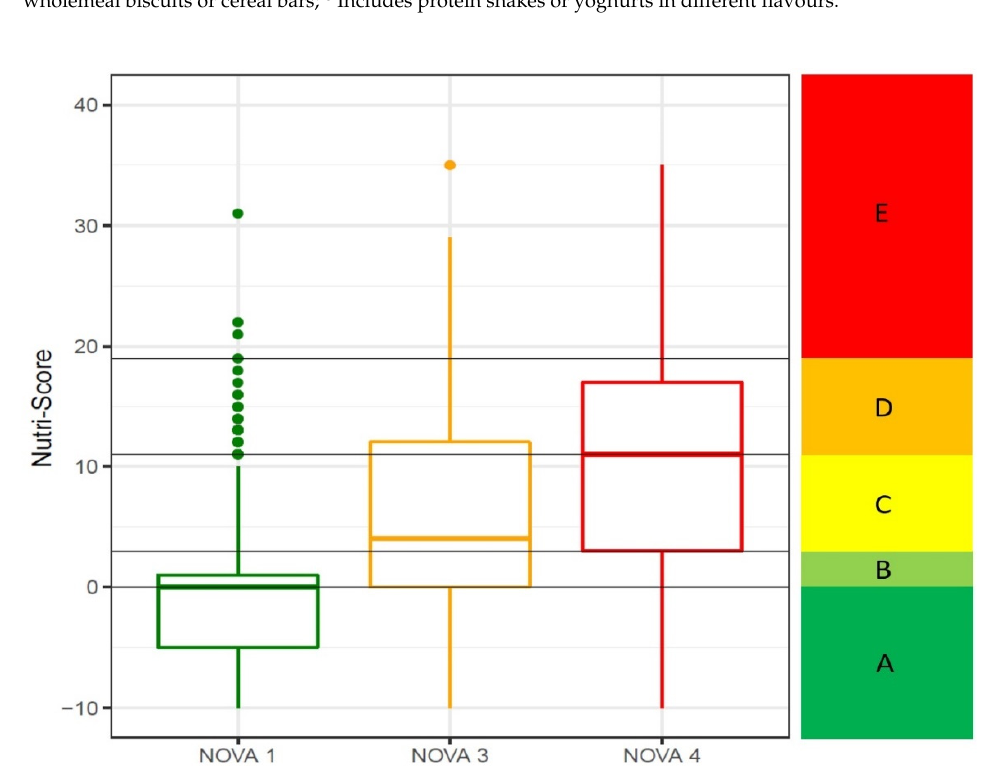
Table 2. Relative contribution of ultra-processed food groups (NOVA 4) in the Nutri-Score A clas- sification.